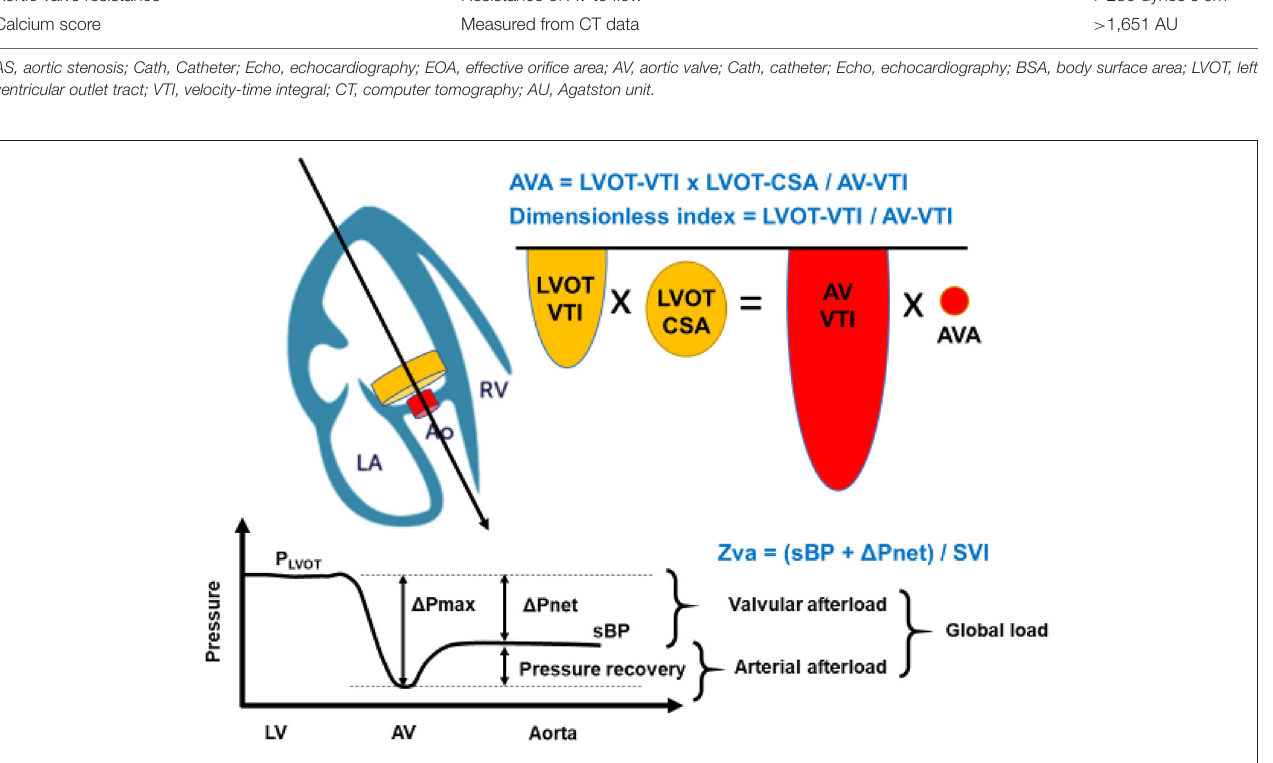
FIGURE 1 | Concept of Aortic Valve Area (AVA) calculation, dimensionless index, and Zva. The calculation of AVA is a standard and must be incorporated into a comprehensive evaluation of aortic stenosis severity. The angle of color Doppler should be accurately aligned. As the LVOT radius is squared to obtain LVOT-CSA in AVA calculation, which may allow inaccuracies and can also contribute substantially to error. The dimensionless index is obtained by LVOT-VTI divided by AV-VTI. The global hemodynamic load imposed on the LV results from the summation of the valvular afterload and the arterial afterload. This global load can be estimated by calculating the valvulo-arterial impedance (Zva). Zva can be calculated with the Doppler mean pressure gradient in place of the 1 Pnet: mean pressure gradient. LA, left atrium; Ao, aortic valve; RV, right ventricle; AVA, aortic valve area; LVOT-VTI, left ventricular outlet tract- velocity time integral; LVOT-CSA, cross sectional area; AV-VTI, aortic stenosis- velocity time integral; Zva, valvulo-arterial impedance; sBP, systolic blood pressure; SVI, stroke volume